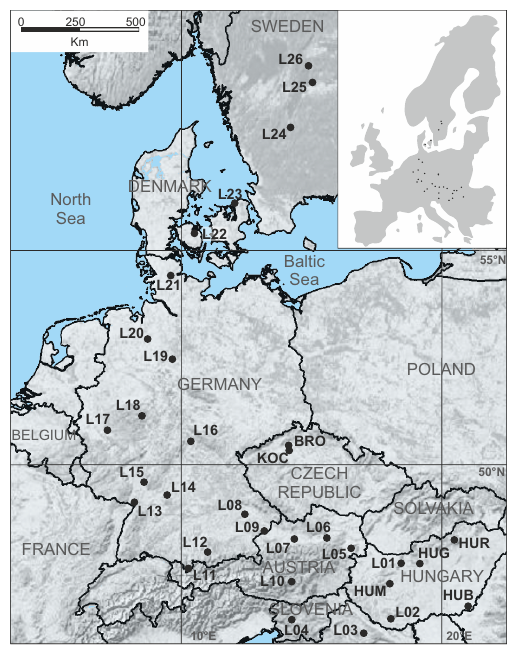
Figure 1. Sample locations (black dots) along the transect (map source: US National Park Service, Esri, HERE, DeLorme, Map- myIndia, OpenStreetMap contributors and the GIS user commu-